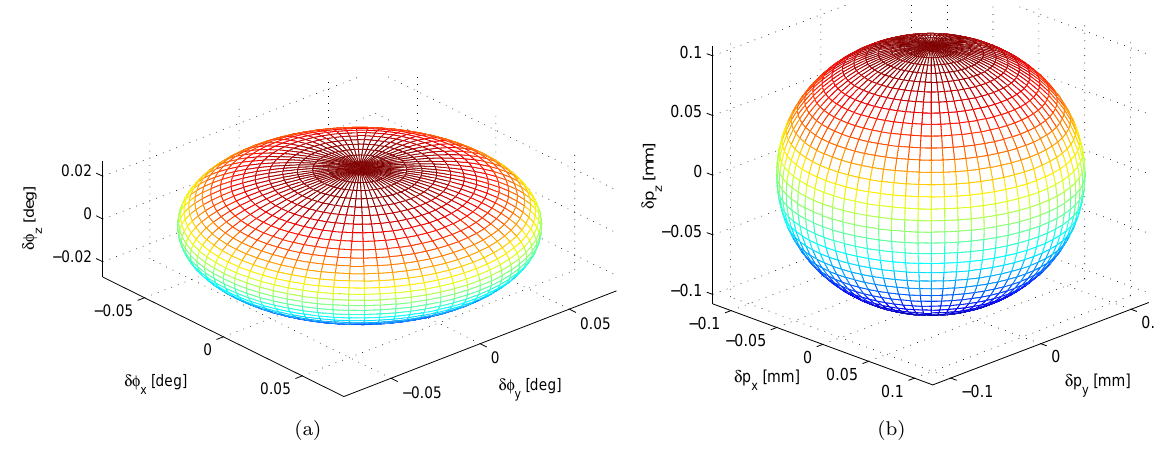
Figure 9: Deformation ellipsoid with orientation of θ = 0 under a pure moment (cid:107) m (cid:107) = 10 Nm: (a) orientation error; (b) translational deformation.